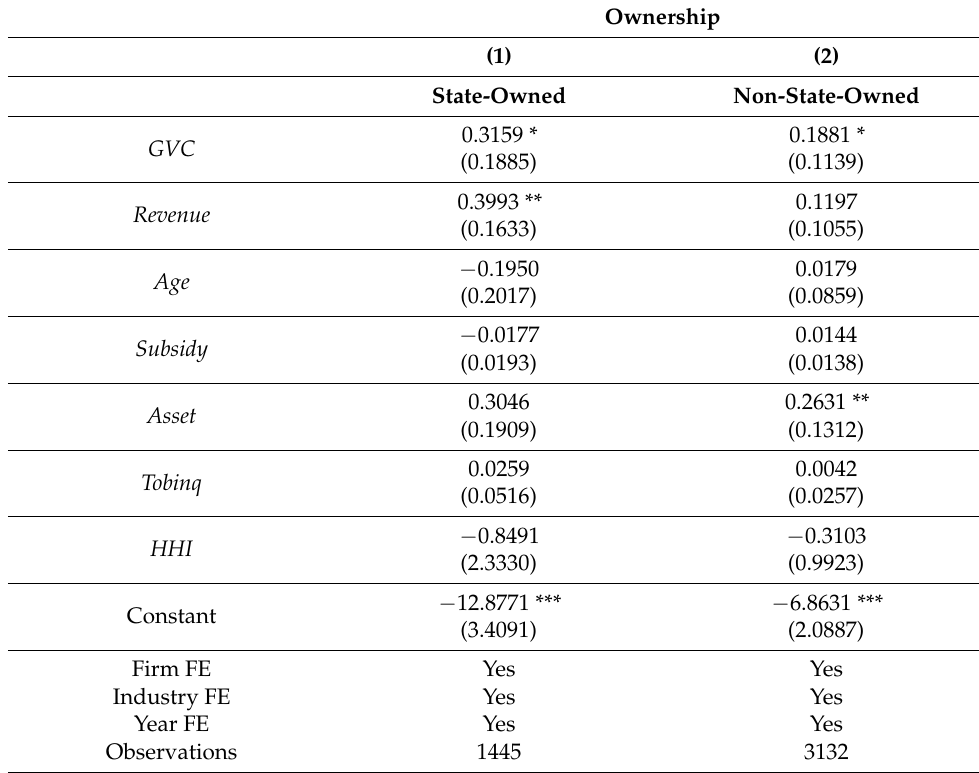
Table 5. Firm heterogeneity analysis: